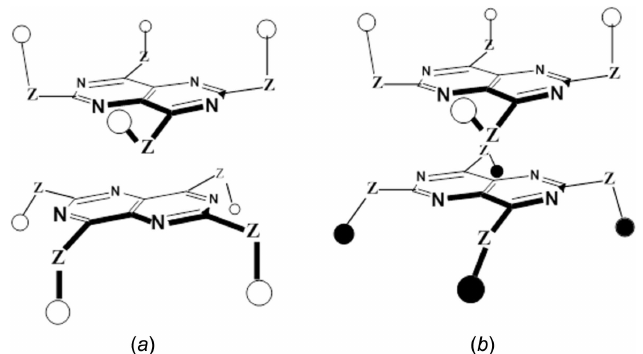
Figure 1 Alternative assembly modes for an extended Piedfort dimer, (uniform array of achiral side-chains where Z represents a link atom or chain. ( a ) one enantiomer with idealized D 2 symmetry. ( b ) idealized C 2 h symmetry, side-chain groups residing in enantiomerically related environments are distinguished by open and filled circle